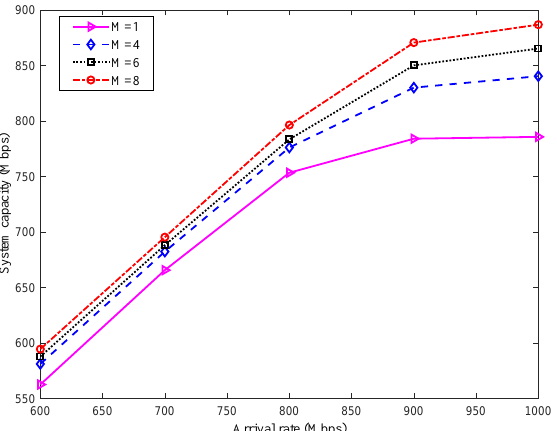
Figure 7. System capacity of different number of DRSs in scenario